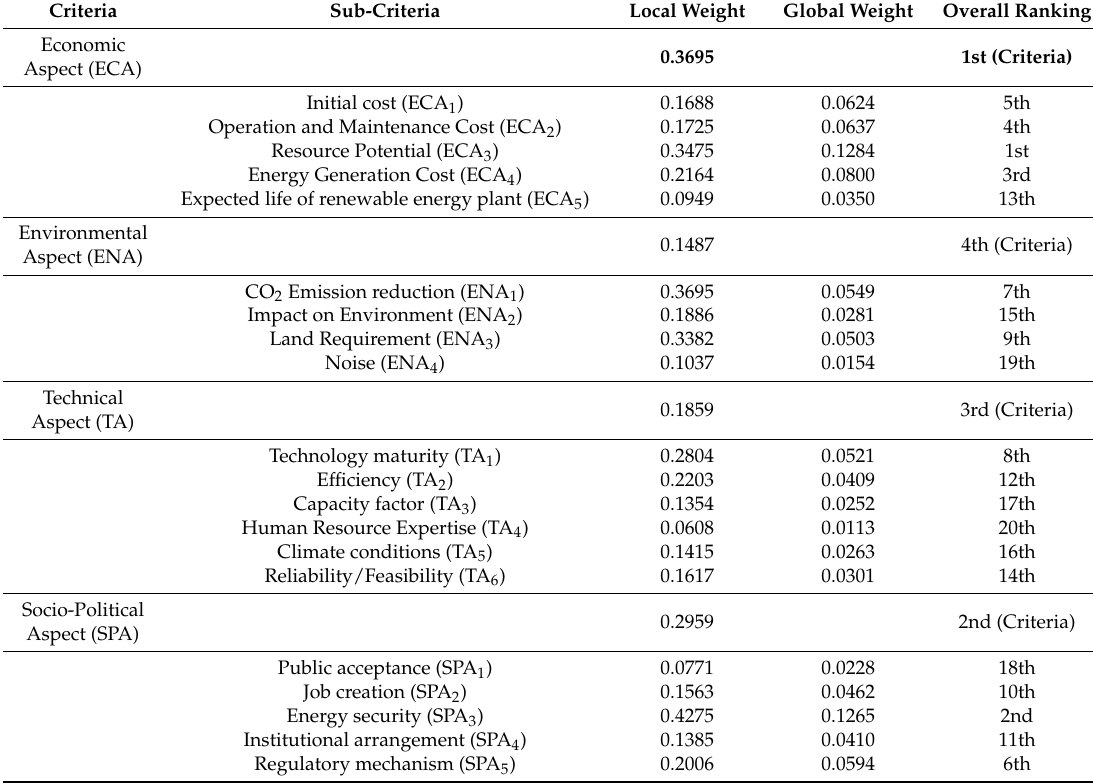
Table 8. Overall priority weight and ranking of criteria and sub-criteria.